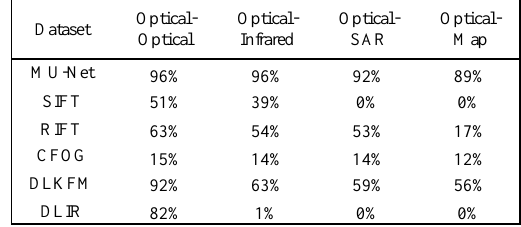
Table 1 . The percentage of test images with the ACE smaller than 3 pixels for comparing mentioned methods.